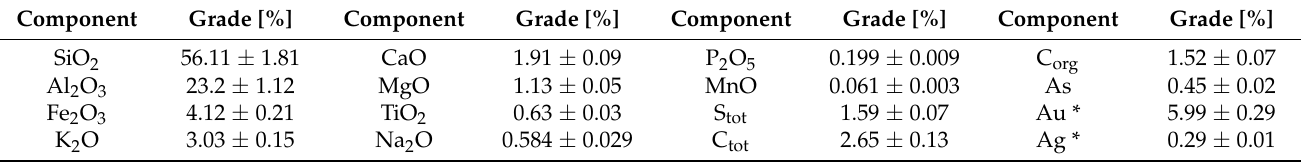
Table 2. Results of the investigation of the chemical composition of CGO.